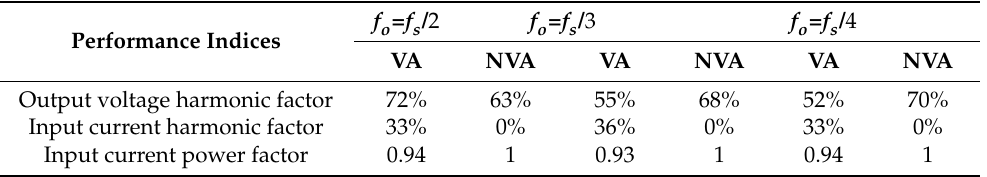
Table 1. Performance evaluation of output voltage and input current with and without voltage adjustment for various output